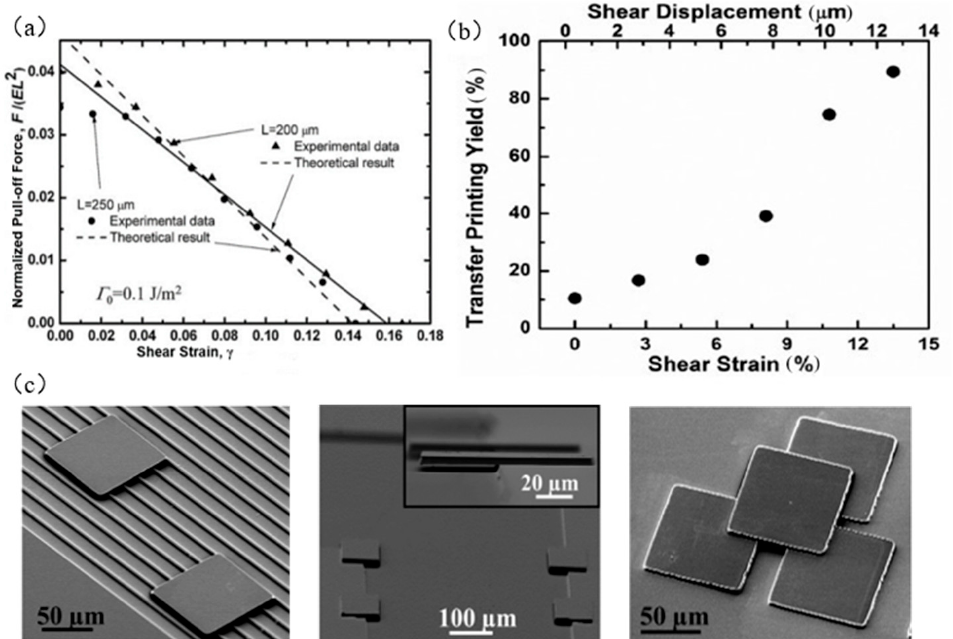
Figure 12. Principles and examples of transfer printing technology with an applied shear load. ( a ) The relationship between the dimensionless peel force and the shear strain γ (reproduced from [84]), ( b ) the relationship between shear strain γ and successful transfer area (reproduced from [73]), and ( c ) examples of small area target substrate printing, hanging structure, and multilayer structure transfer (reproduced from [73]).